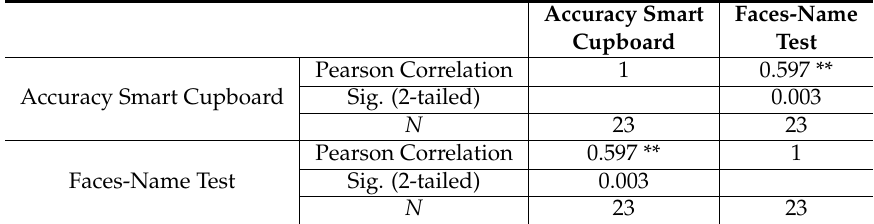
Figure 10. Comparison of memory measurements between the smart cupboard (SC) and the face–name pairs test. Table 3. Correlation between the accuracy of the SC and the accuracy of the face–name